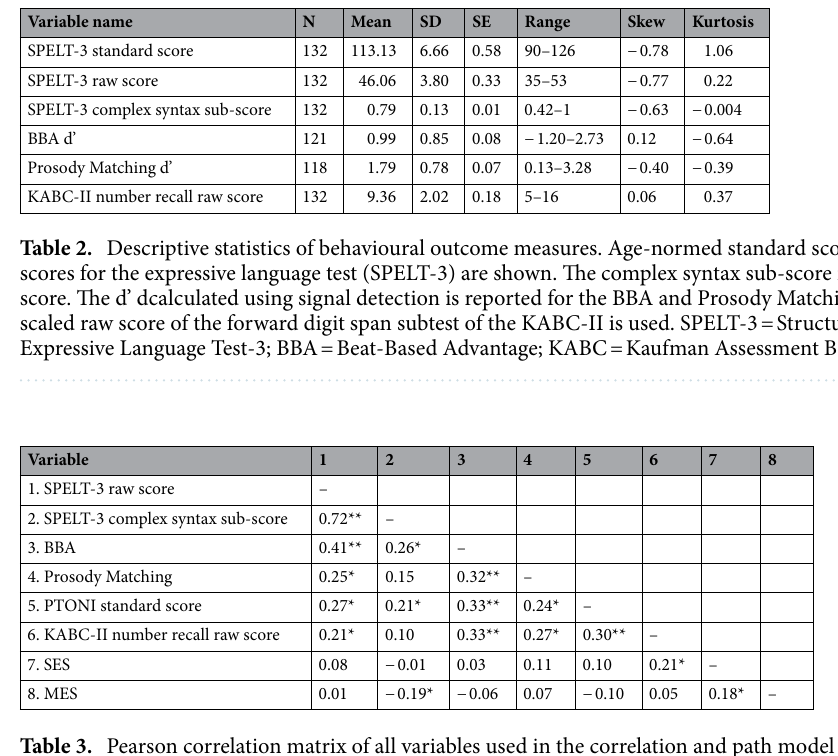
Table 3. Pearson correlation matrix of all variables used in the correlation and path model analysis. Except for the PTONI age-normed standard scores (which are the z-scored standard scores), the raw scores of all other variables were z-scored, regressed on age, and the resulting residuals were z-scored once again, and these z-scored, age-regressed residuals were used in the correlation matrix. Values are correlation r values for each pair of variables. Missing values were excluded in a pair-wise manner. SPELT-3 = Structured Photographic Expressive Language Test; BBA = Beat-Based Advantage; PTONI = Primary Measure of Non-Verbal IQ; KABC = Kaufman Assessment Battery for Children; SES = Socioeconomic Status; MES = Musical Experience Score. *indicates p < 0.05, and **indicates p <